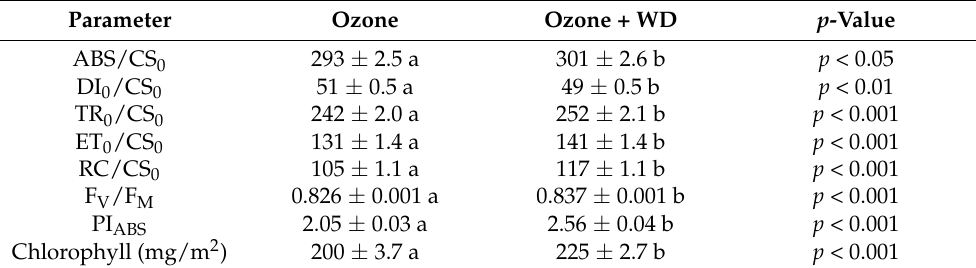
Different letters indicate statistically significant ( p < 0.05) differences between treatments. Abbreviations: ab- sorbance for excited cross-section (ABS/CS 0 ), heat dissipation for excited cross-section (DI 0 /CS 0 ), trapping flux for excited cross-section (TR 0 /CS 0 ), energy transmission for excited cross-section (ET 0 /CS 0 ), number of reaction centers for excited cross-section (RC/CS 0 ), photosynthetic efficiency (F V /F M ), performance index (PI ABS ), chlorophyll content